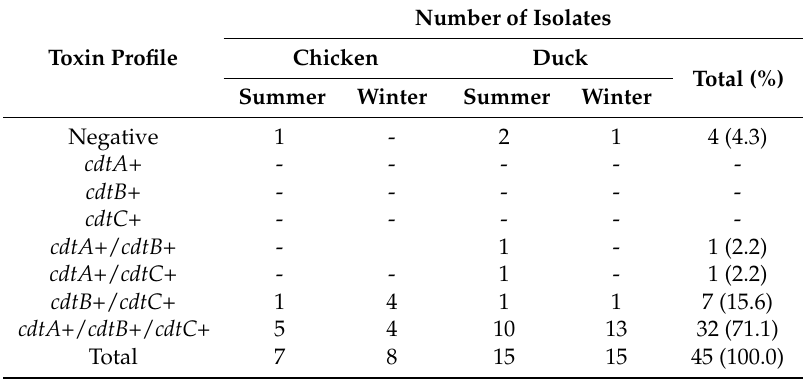
Table 5. Cytolethal Distending Toxin (CDT) gene profiles of Campylobacter isolated from chicken and duck carcasses at wet markets. Number of Isolates Chicken Duck Toxin Profile Total (%) Summer